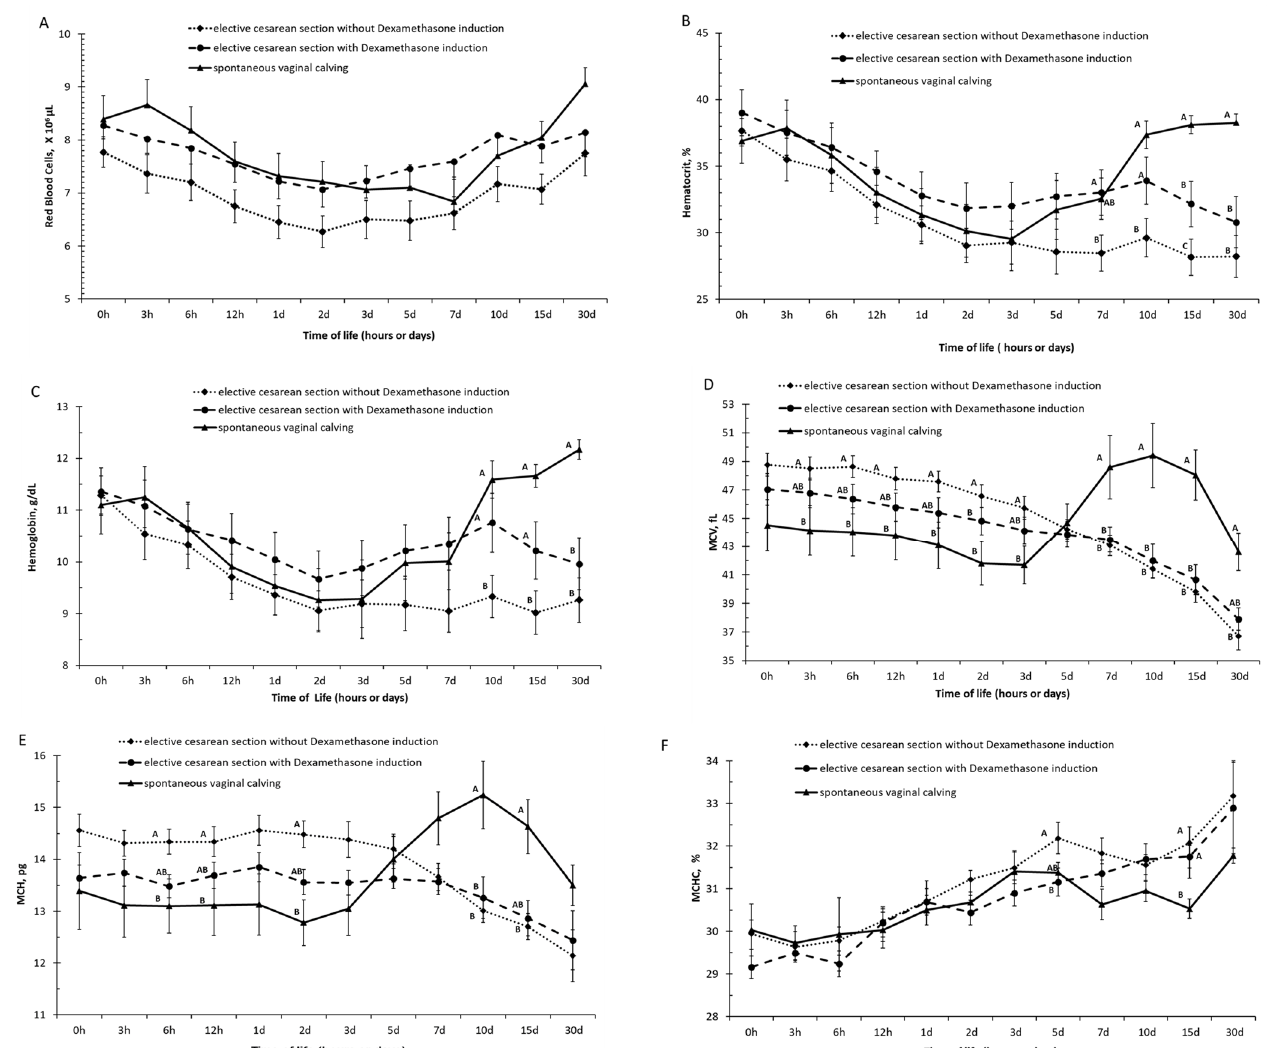
Figure 1. ( A ) Red blood cells, ( B ) hematocrit, ( C ) hemoglobin, ( D ) mean corpuscular volume (MCV), ( E ) mean corpuscular hemoglobin (MCH), and ( F ) concentration of mean corpuscular hemoglobin (MCHC) in calves born by spontaneous vaginal calving ( n = 10) and elective cesarean calving with ( n = 14) or without ( n = 14) induction during the first month of life. A, B, C – Different letters on the line mean statistically significant difference compared with Tukey’s teste, at 5% significance.